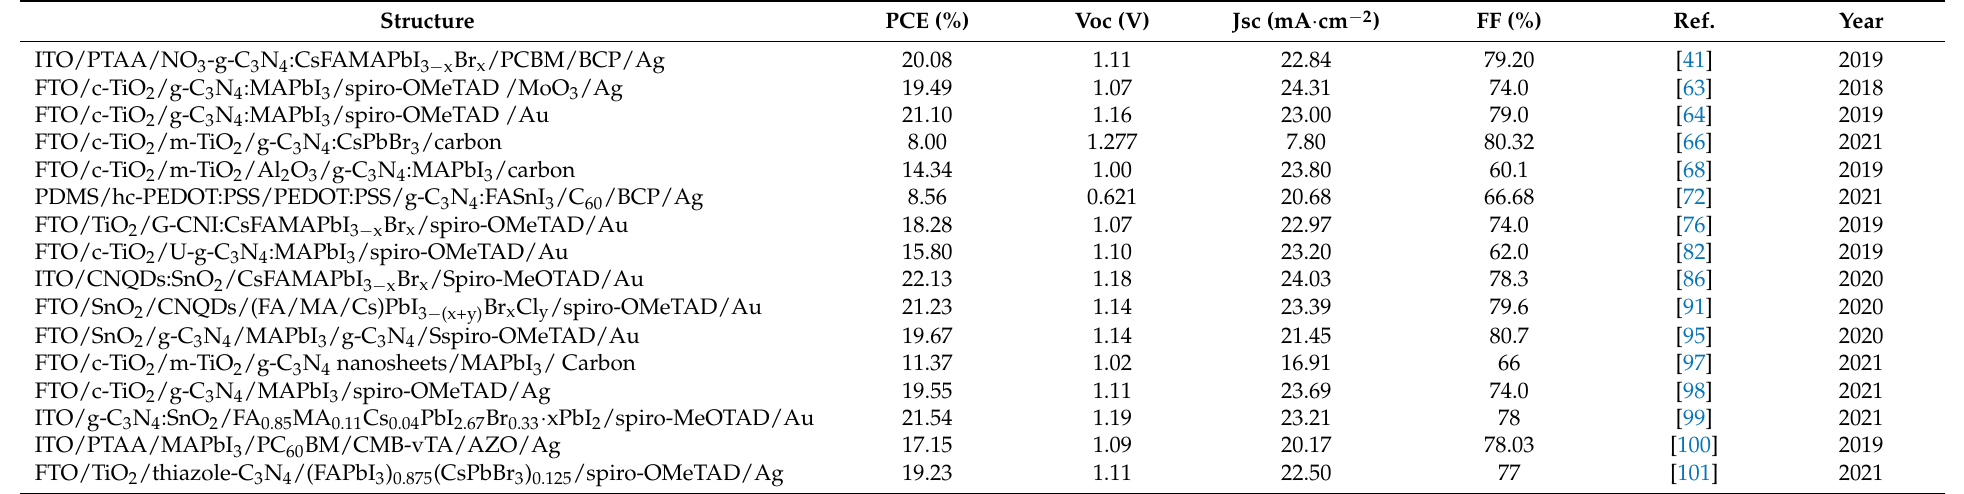
Table 1. Recent development of g–C 3 N 4 based PSCs photovoltaic performance.